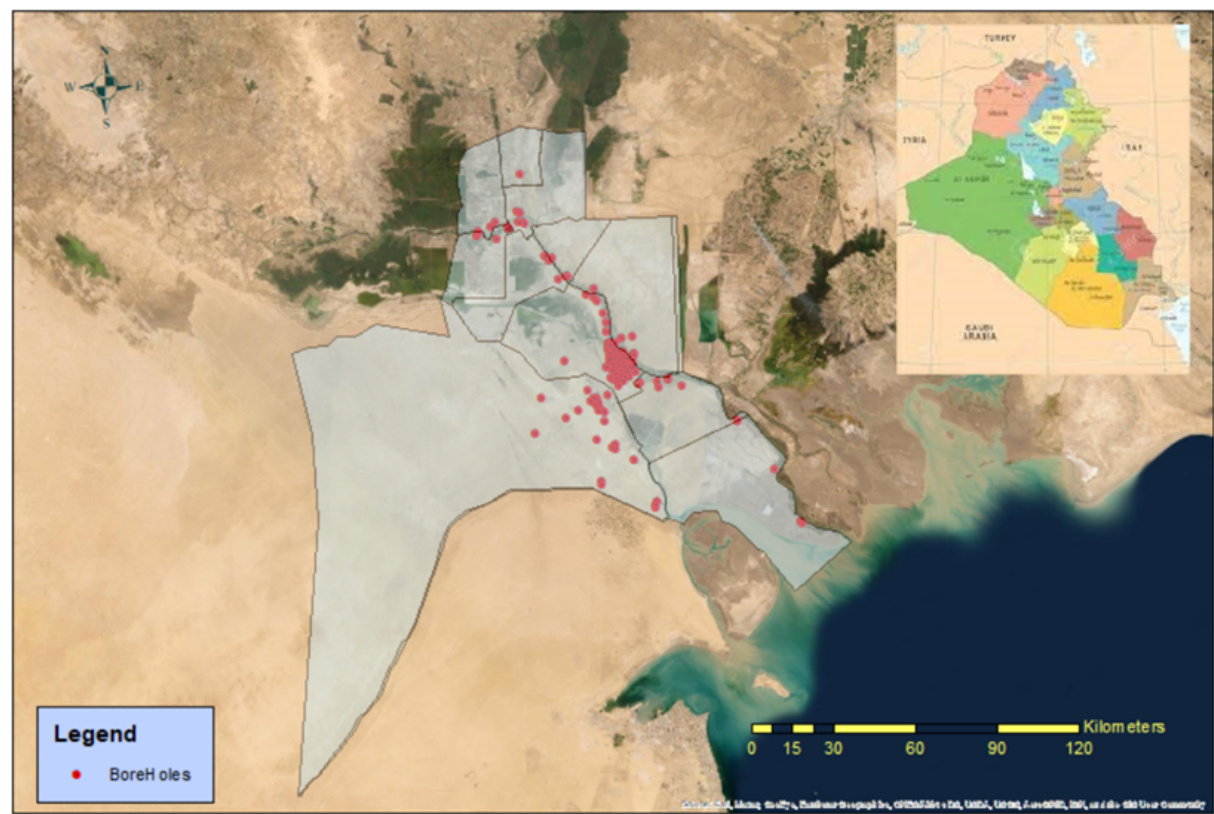
Figure 1: Distribution of the boreholes (source: Google